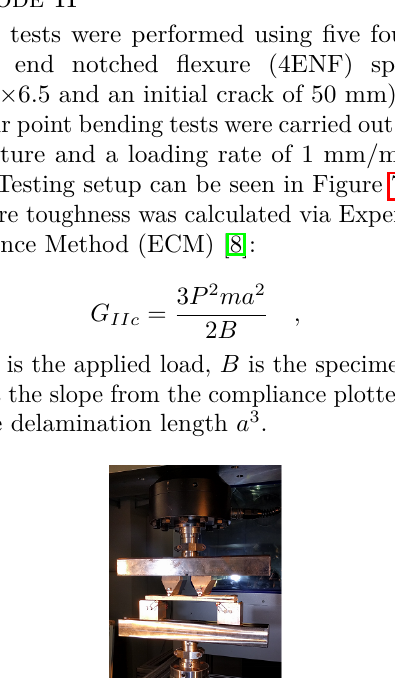
Figure 4. C-SMC plate: milled specimen pattern